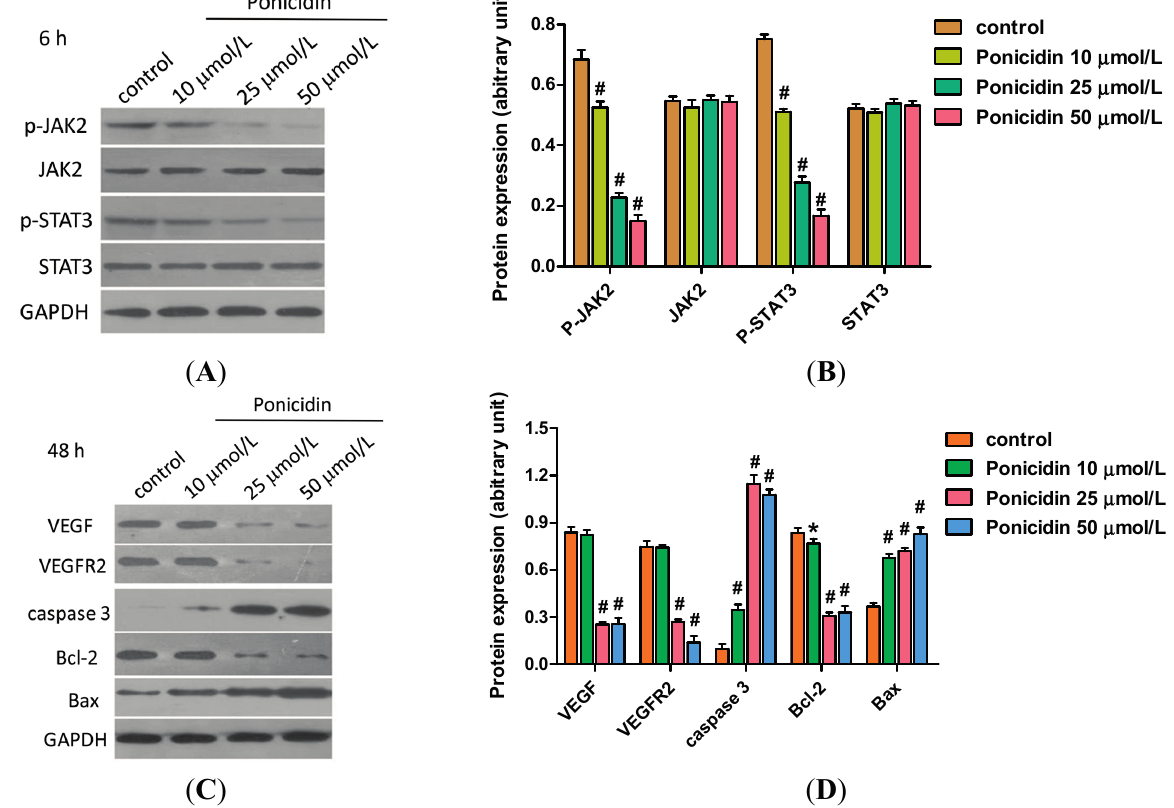
Figure 5. Effects of ponicidin on the expression of key proteins involved in cell apoptosis. ( A , C ) The expression of apoptosis-related proteins was detected by Western blot; ( B ) Treatment with ponicidin for 6 h: JAK2 and STAT3 phosphorylation decreased dose-dependently and no effects of ponicidin (50 μ g/mL) on JAK2 and STAT3 were observed; and ( D ) Treatment with ponicidin (25, 50 μ g/mL) for 48 h increased the expression of Bax and the active form of caspase-3, while it decreased the expression of VEGF, VEGFR2 and Bcl-2, dose-dependently. * p < 0.05, # p <